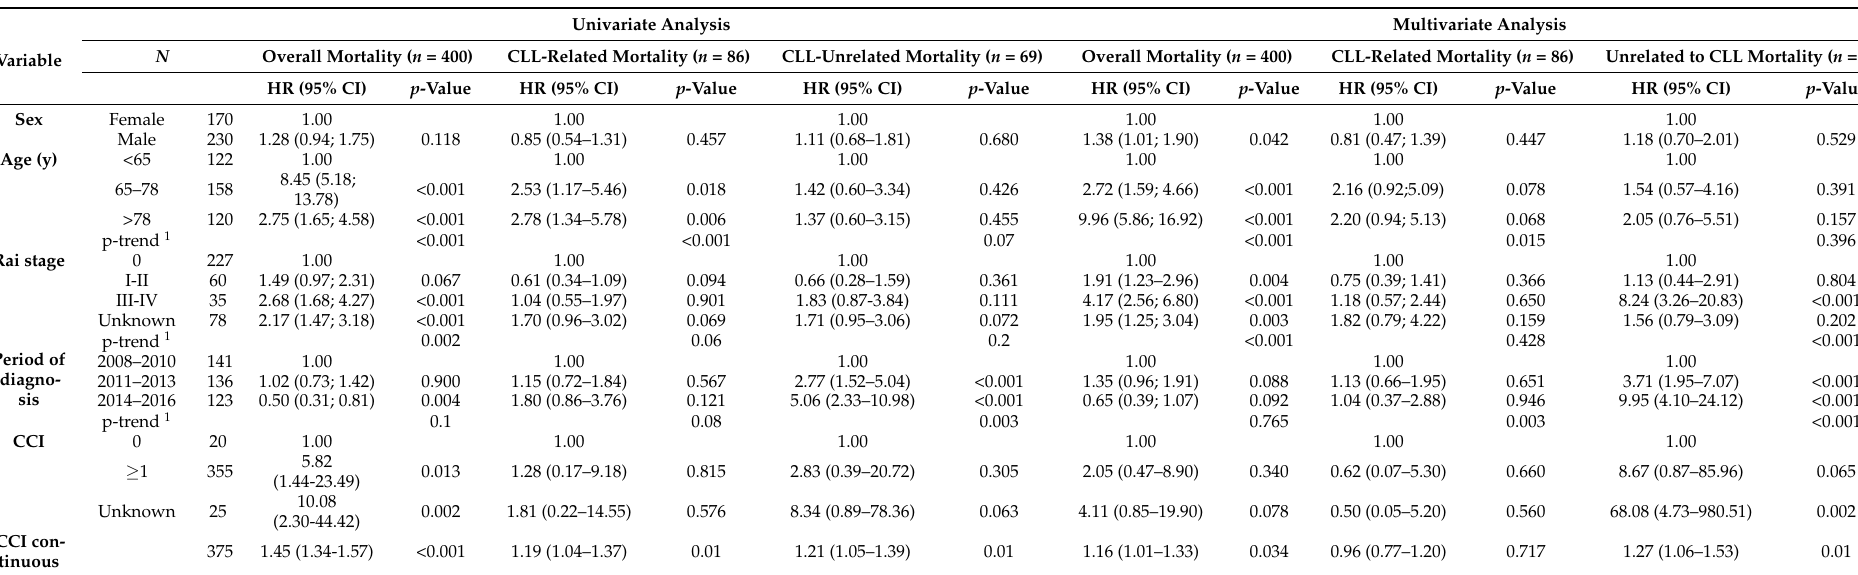
Table 3. Univariate and multivariate analysis of mortality (overall, CLL-related, and CLL-unrelated) in patients with chronic lymphocytic leukemia in Girona (2008–2016). Univariate Analysis Multivariate Variable